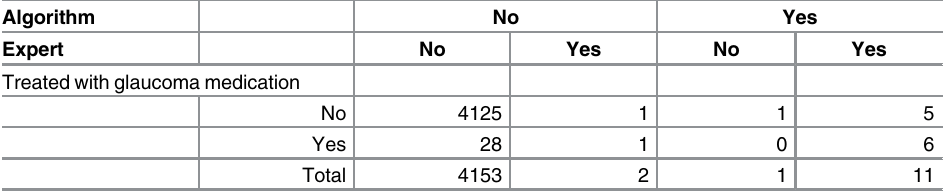
Table 9. Subjects treated with glaucoma medication and relation to the algorithm ’ s and to expert ’ s decision on the prevalence of probable glaucoma suspects.